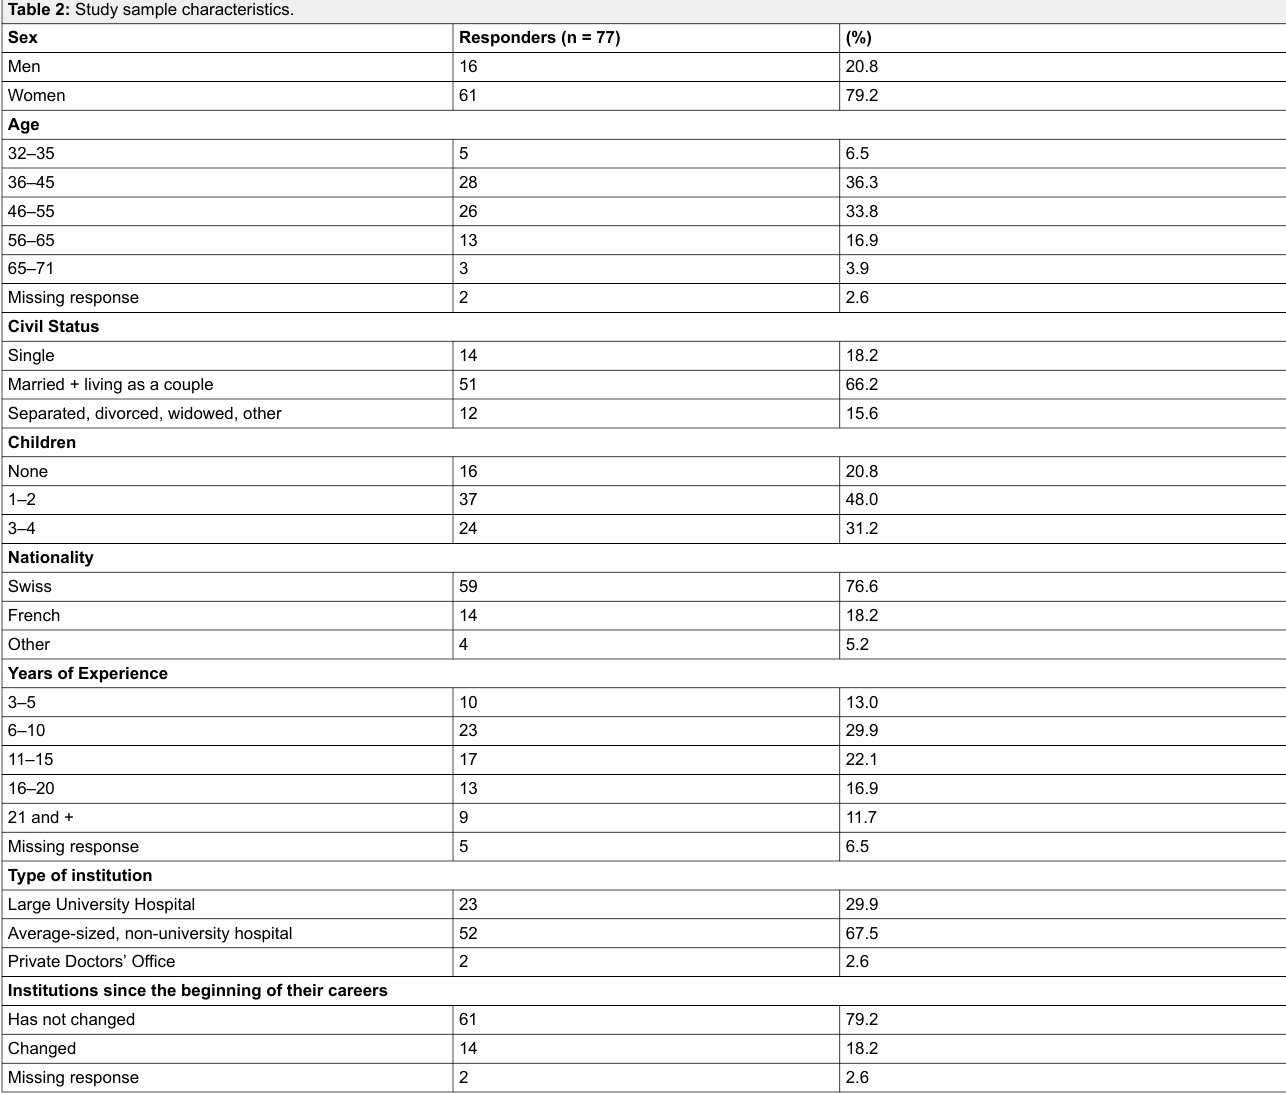
Table 2: Study sample